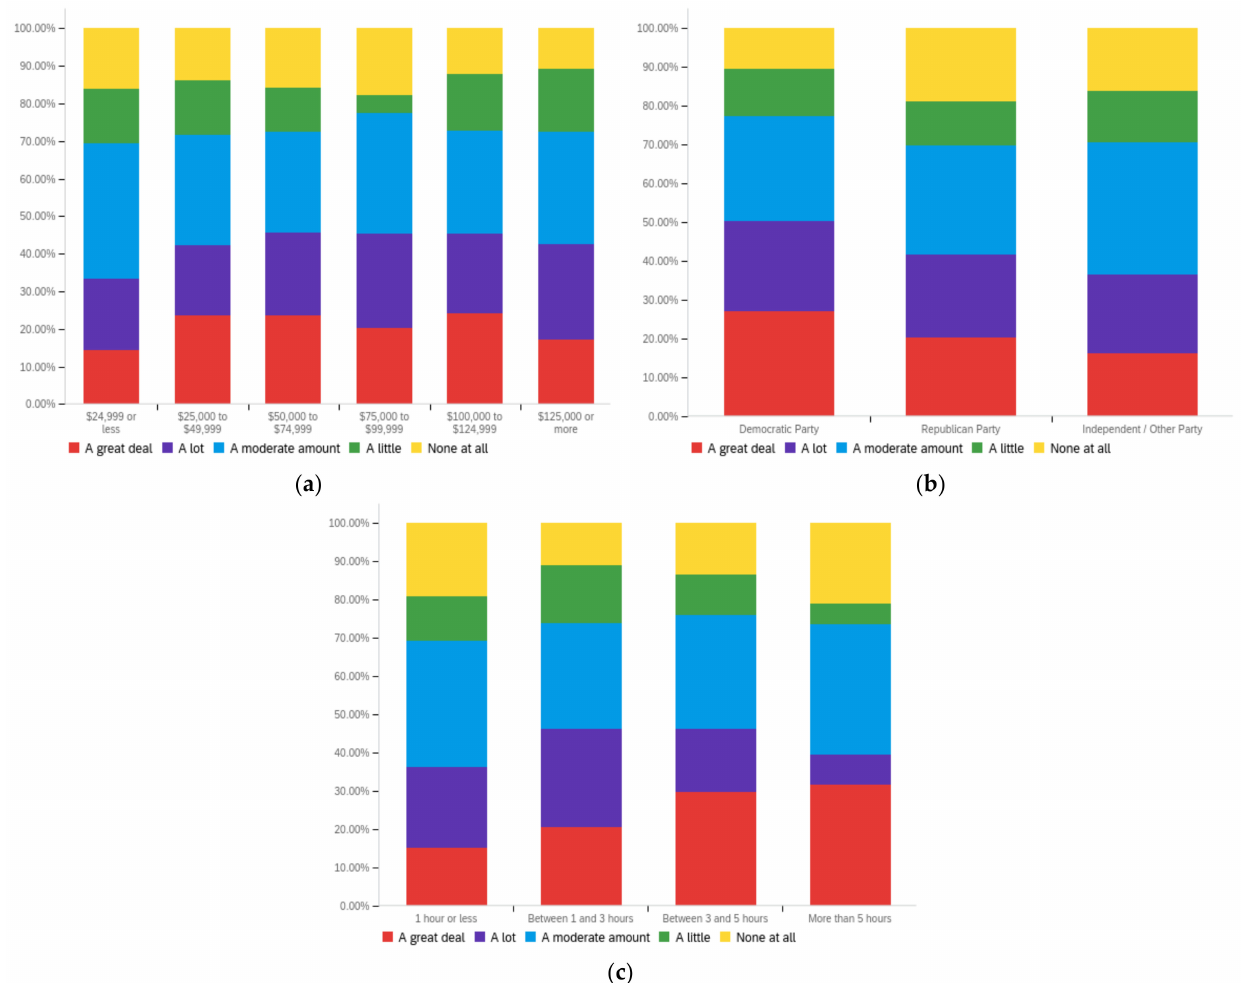
Figure A24. Article sponsor’s political alignment—ideal perception impact by: ( a ) income level (top left), ( b ) political affiliation (top right) and ( c ) online usage